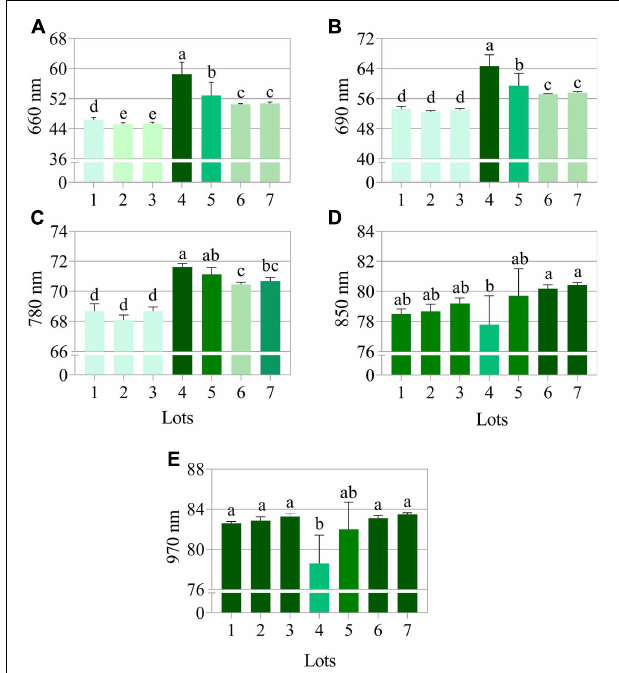
FIGURE 8 | Reflectance mean of seven peanut seedlots ( Arachis hypogaea L.; cv. IAC OL3) at (A) 660, (B) 690, (C) 780, (D) 850, and (E) 970 nm (previously shown as the best wavelengths to discriminate seeds as high and low vigor) ( n = 170). Means ( ± standard deviation) with different letters indicate a significant difference ( p ≤